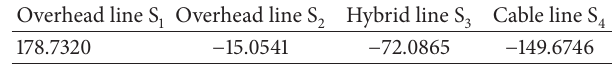
Table 1: First half-wave